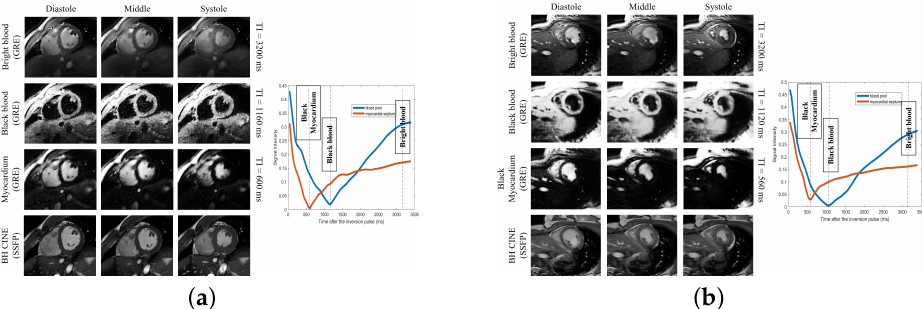
Figure 3. ( a ) Results on subject #1. ( b ) Results on subject #6. Generation of synthetic breath-hold cine data with different contrasts. We show the results on two subjects in ( a , b ), respectively. In each figure, the top three image rows on the left correspond with the synthetic breath-hold cine at three representative inversion times. The images from the 2D conventional gated Cartesian cine images acquired using the balanced SSFP sequence are also shown in the bottom row for comparison purposes. The right side of each sub-figure is the plot of the signal evolutions of the myocardium and blood